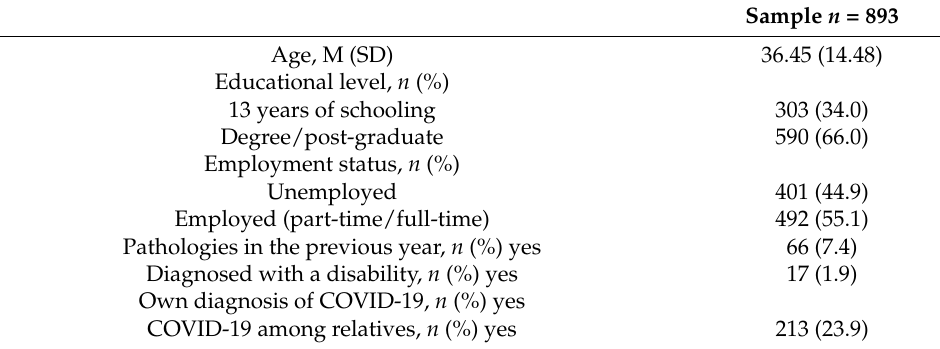
Table 1. Demographics and health-related